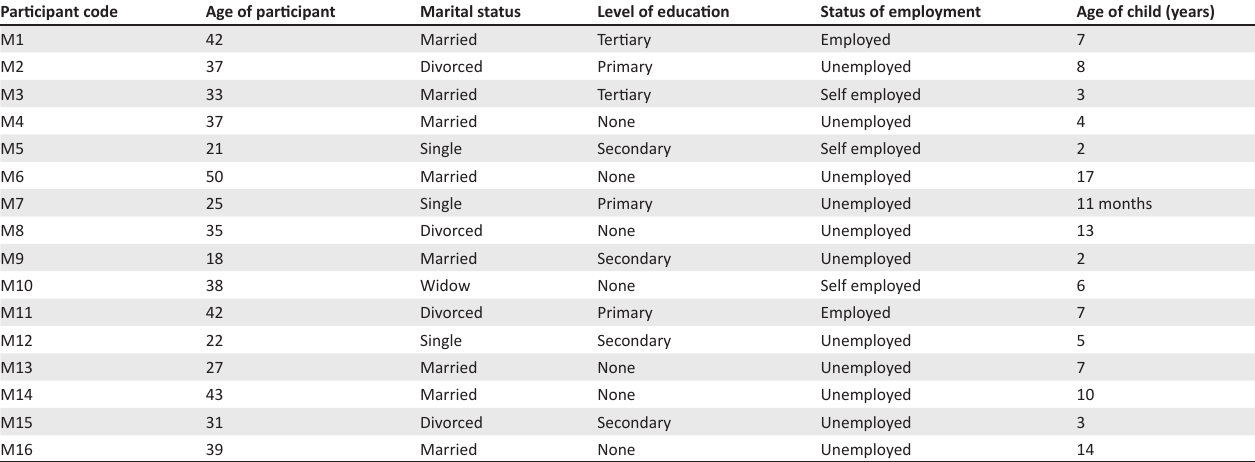
TABLE 1: Demographic data for participants and their children with cerebral palsy. Participant